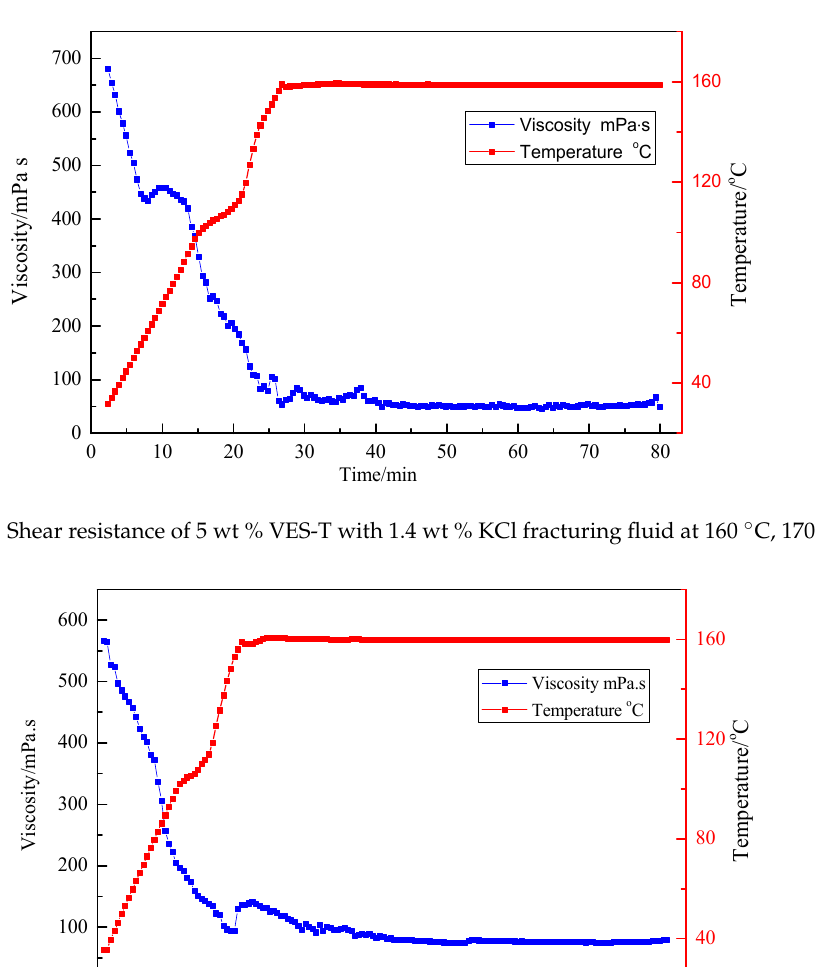
Figure 6. Shear resistance of 5 wt % VES-T with 1.2 wt % NaSal fracturing fluid at 160 °C, 170 s − 1 .